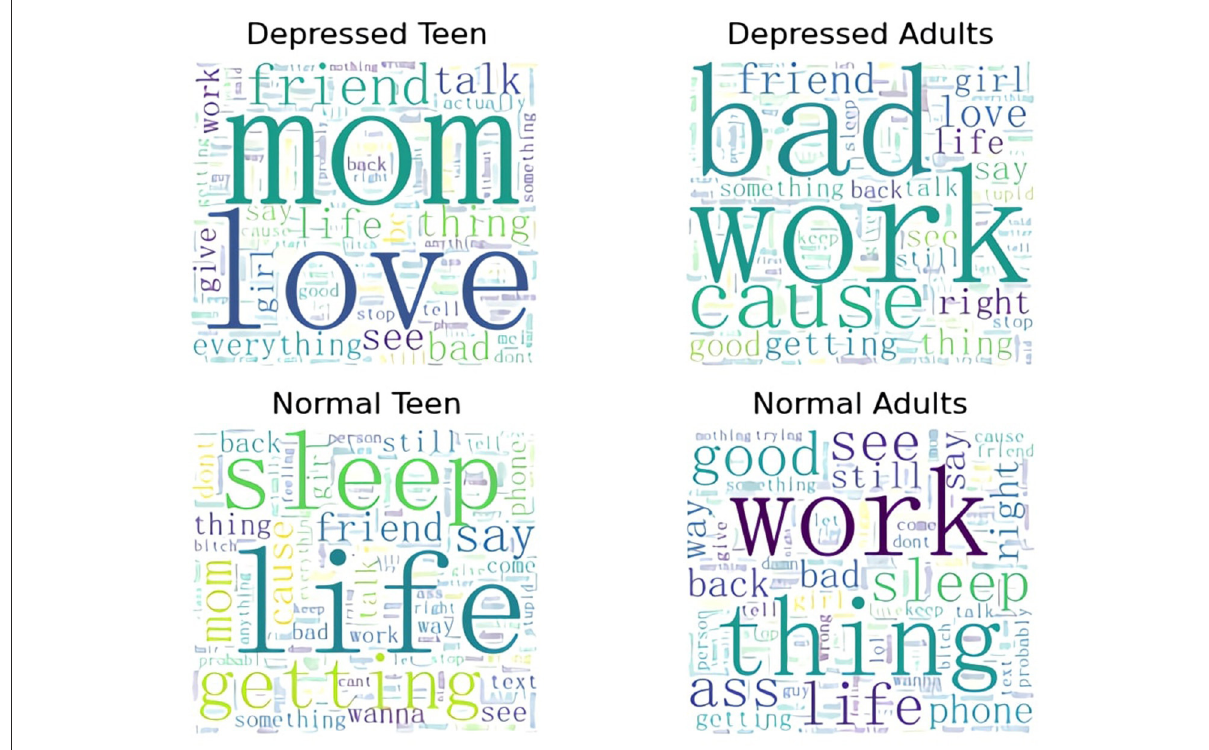
FIGURE6 This image shows which words previous cognitive distortions focus on in various groups of people.